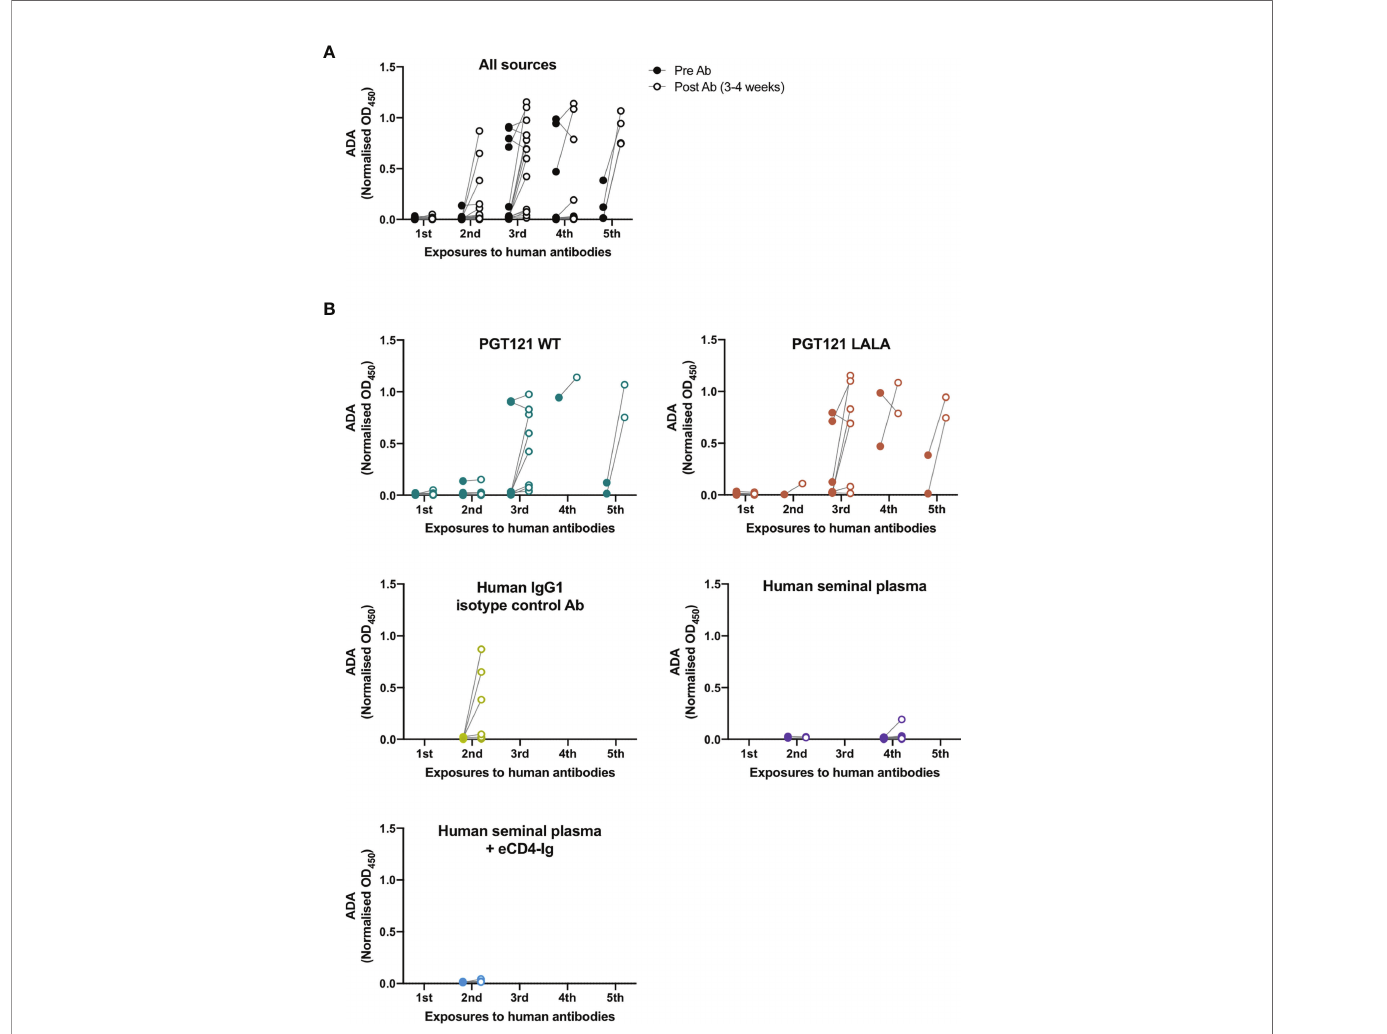
FIGURE 4 | Anti-PGT121 ADA increases with the number of exposures to human antibodies. (A) The level of anti-PGT121 ADA in macaques before (closed circles) and 3-4 weeks after (open circles) exposure to human antibodies. (B) The level of anti-PGT121 ADA before and after exposure to different sources of human antibodies (intravenous administration of PGT121 WT, PGT121 LALA, eCD4-Ig and human IgG1 isotype control antibody or intrarectal/intravaginal administration of human seminal